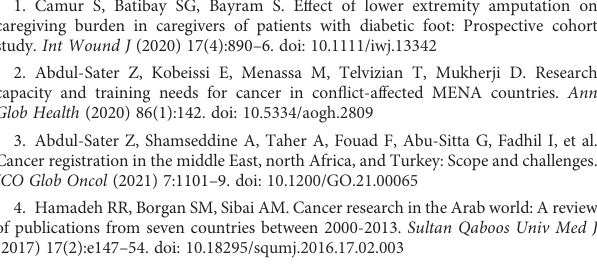
SUPPLEMENTARY FIGURE 2 The percentage change in the number of cancer research publications in FCS in the MENA region from 2000 to 2021. SUPPLEMENTARY FIGURE 3 The number of publications per 100K people on cancer research in FCS per country and the median GDP per capita (current US$) between 2000 to 2021. SUPPLEMENTARY FIGURE 4 Word cloud for top keywords of cancer research in FCS in the MENA region from 2000 to 2021. The importance of these single words is re fl ected by the font size or